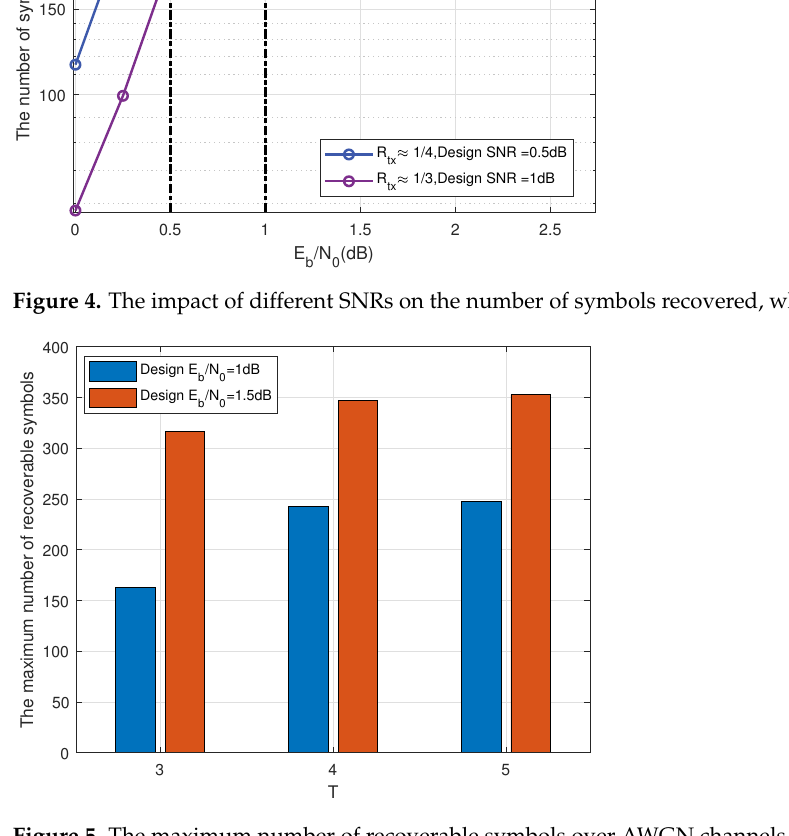
Figure 5. The maximum number of recoverable symbols over AWGN channels with different values of T , for N = 1024 and design E b / N 0 = 1 and 1.5